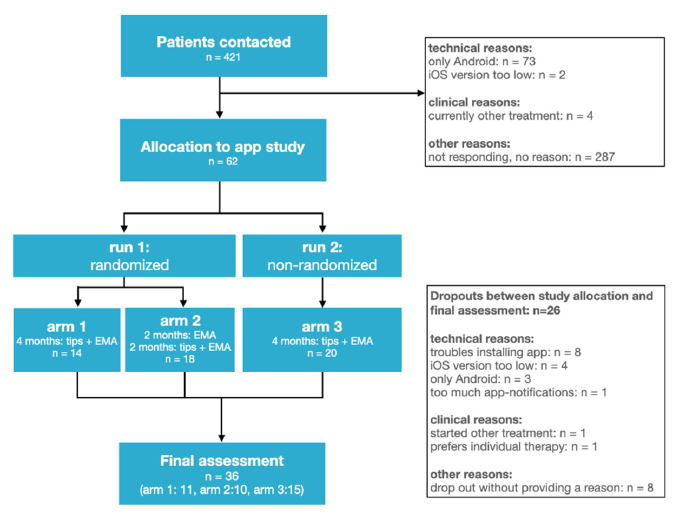
Figure 1. Participant flow diagram. In treatment arm 1 and 3, participants received four months of smartphone-guided educational counseling treatment plus Ecological Momentary Assessment. In treatment arm 2, participants received for two months, Ecological Momentary Assessment